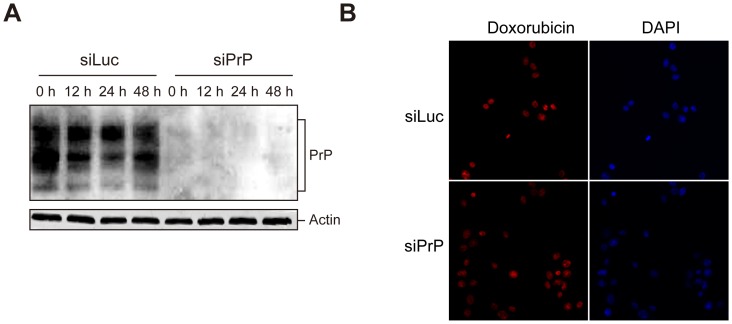
PrP expression level and endogenous fluorescence of doxorubicin during and after doxorubicin treatment.(A) Immunoblot analysis of the PrP expression level in siLuc and siPrP cells after incubated with 1.25 µg/mL doxorubicin for indicated time. (B) The endogenous fluorescence of doxorubicin after incubating with 1.25 µg/mL doxorubicin 30 hours. Nuclei were stained with DAPI as indicated.